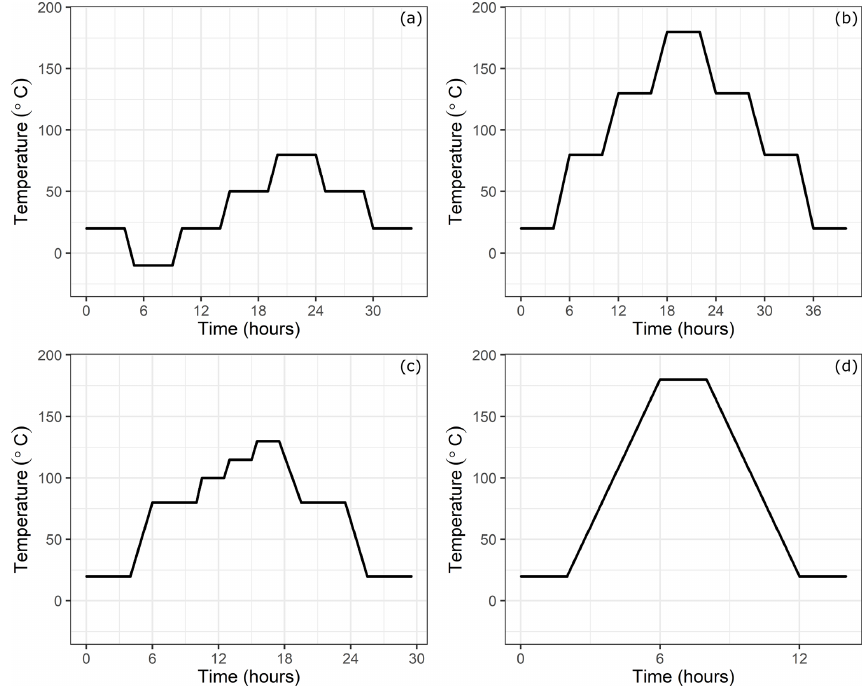
Figure 2. Temperature setting at the climate cabinet: (a) low-temperature experiments, (b) high-temperature experiments, (c) experiments until 130 ◦ C and (d) high-temperature experiments for only 180 ◦